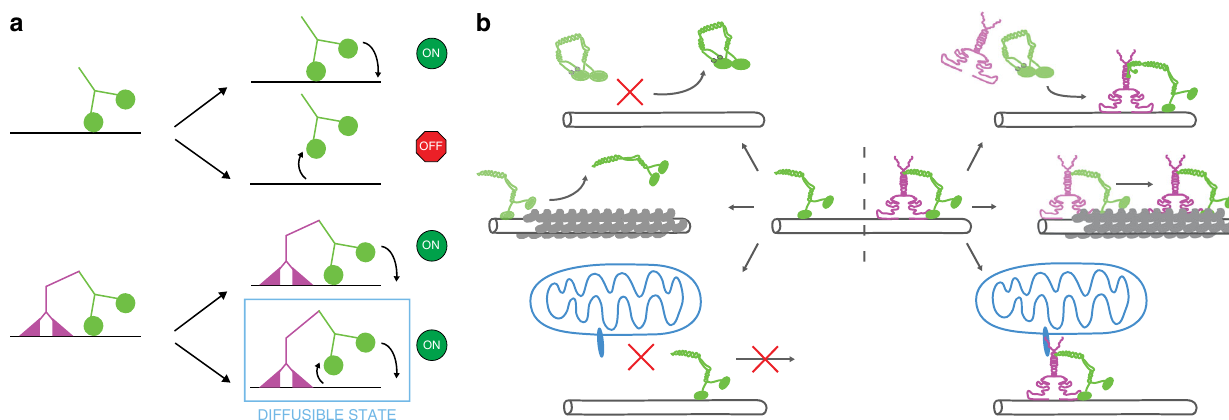
Fig. 6 Schematic illustration of the TRAK1-mediated anchoring of KIF5B. a Top: in absence of TRAK1, KIF5B (green) can either continue its walk by rebinding the disengaged motor domain to the microtubule or dissociate from the microtubule when the engaged motor domain unbinds from the microtubule. Bottom: in presence of microtubule-bound TRAK1 (magenta), when both motor domains of KIF5B disengage from the microtubule, KIF5B remains tethered to the microtubule through a diffusive interaction of TRAK1 with the microtubule and thereby enables the rebinding of a motor domain of KIF5B to the microtubule. In this state, TRAK1 might facilitate navigation around obstacles by diffusion along the microtubule surface. b Overview of the functions of TRAK1. Top: TRAK1 activates auto-inhibited KIF5B, enabling its processive movement along microtubules. Middle: TRAK1 increases the processivity of KIF5B in crowded environments. Bottom: TRAK1 enables KIF5B-based transport of isolated mitochondria along microtubules in